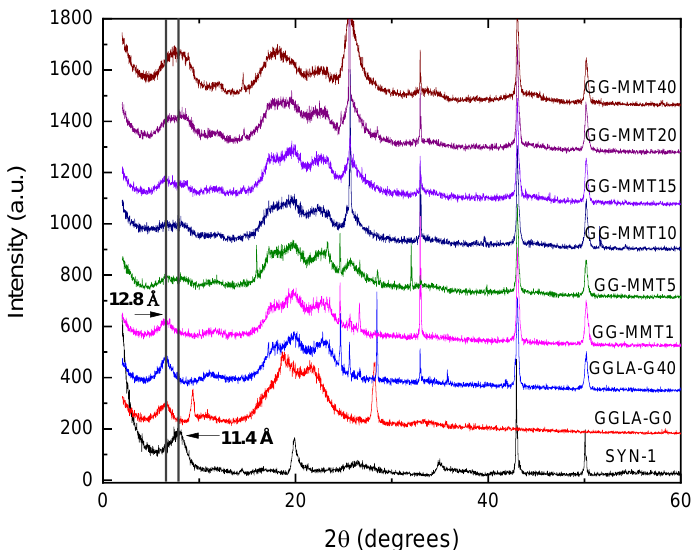
Figure 5. DRX diffractograms of Na + SYN-1 clay; GGLA-G0 and GGLA-G40 SPEs; and GG-MMT1 to GG-MMT40 NPEs.